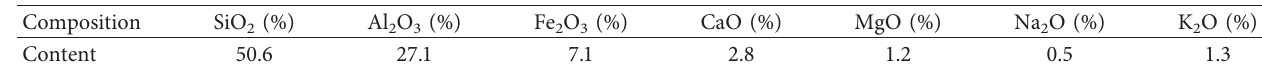
Table 2: Chemical composition of coal ash.